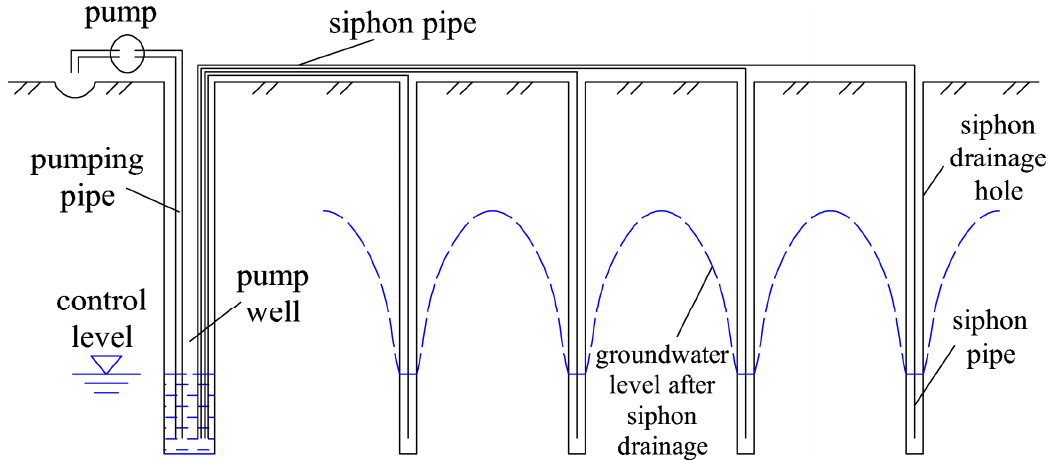
Figure 2. Schematic diagram of siphon drainage pro fi le structure in soft soil.